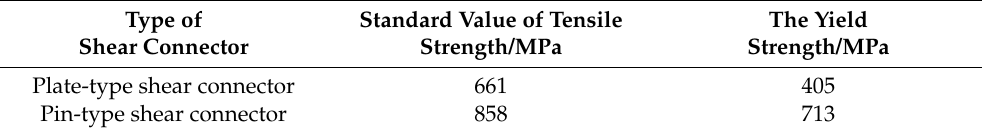
Table 2. Performance parameters of stainless steel shear